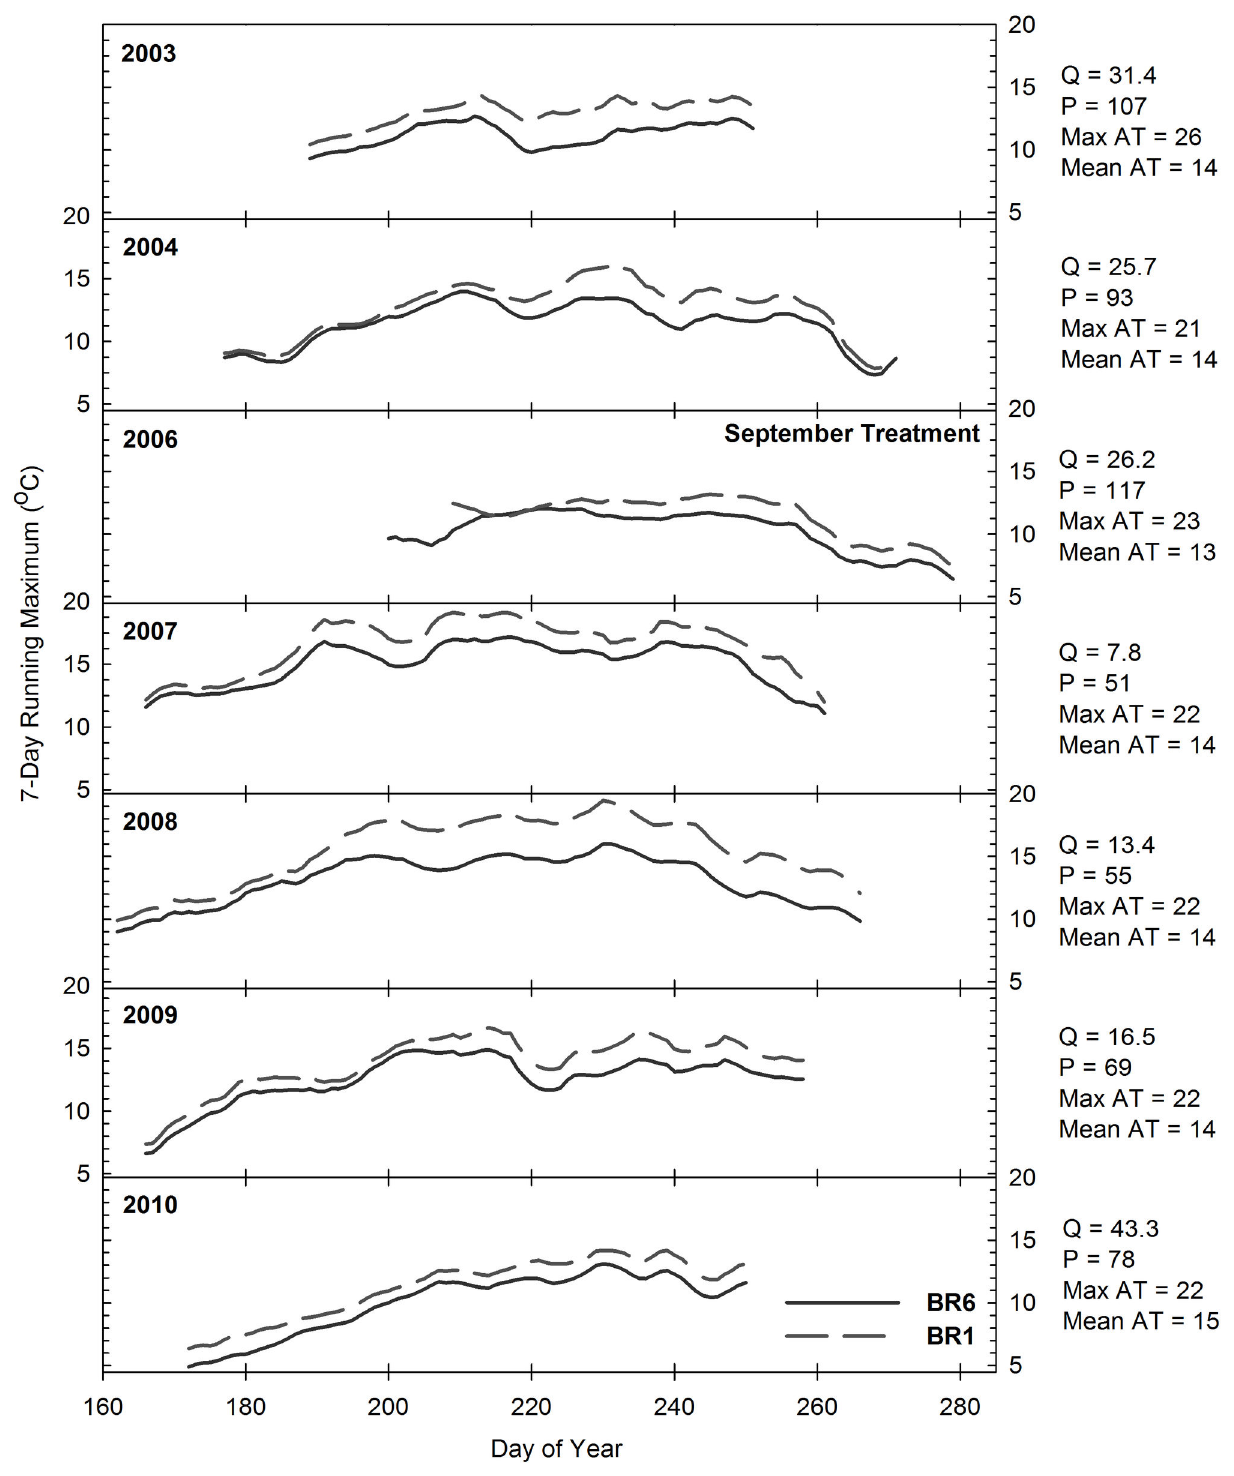
Figure 7. Seven day running average daily maximum water temperature (°C) on Bailey Creek. Stations BR6 and BR1 were located immediately upstream and downstream of the areas treated during the Bailey Project, respectively. Q = mean discharge (m 3 min -1 ) from Jun 15 – Aug 31, P = percent of mean annual precipitation, Max AT = mean of daily maximum air temperature (°C) from Jun 15 – Aug 31, AT = mean of average daily air temperature (°C) from Jun 15 – Aug 31. doi: 10.1371/journal.pone.0084561.g007 PLOS ONE |